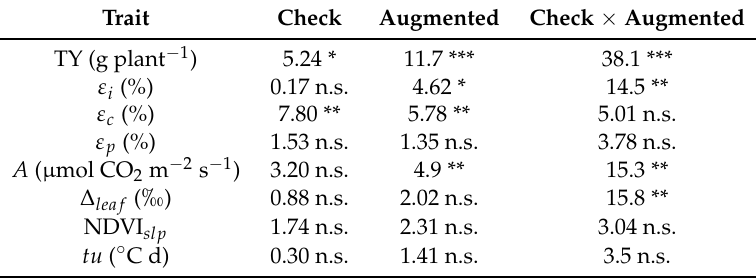
Table 1. F-values corresponding to the analysis of variance for an augmented block